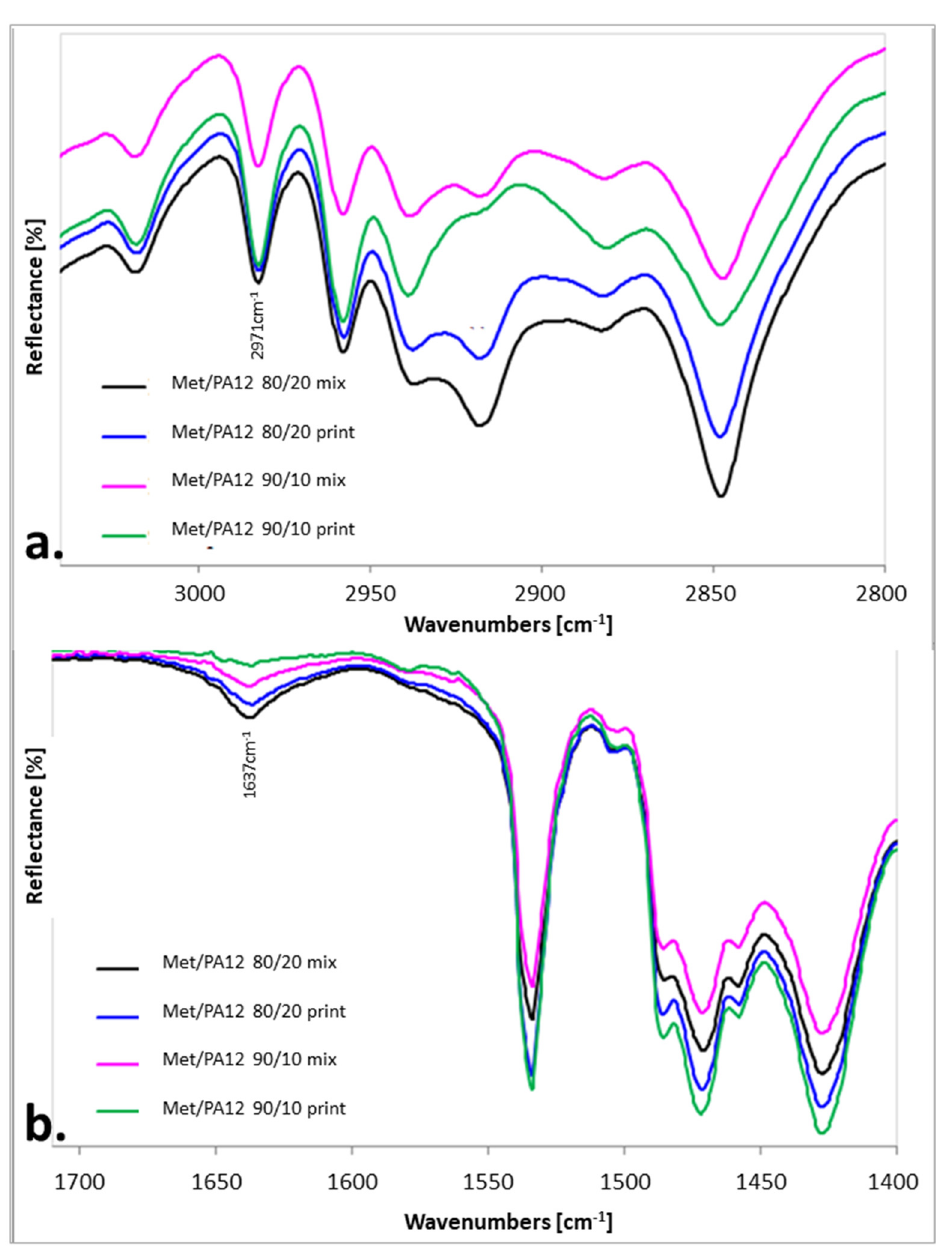
Figure 7. IR-ATR spectra of the printlets and corresponding physical mixtures ( a ) in the range of − 1 ; ( b ) in the range of 1710–1400 cm − 1 3040–2800 cm − 1 ; ( b ) in the range of 1710–1400 cm − 1 . 3040–2800 cm